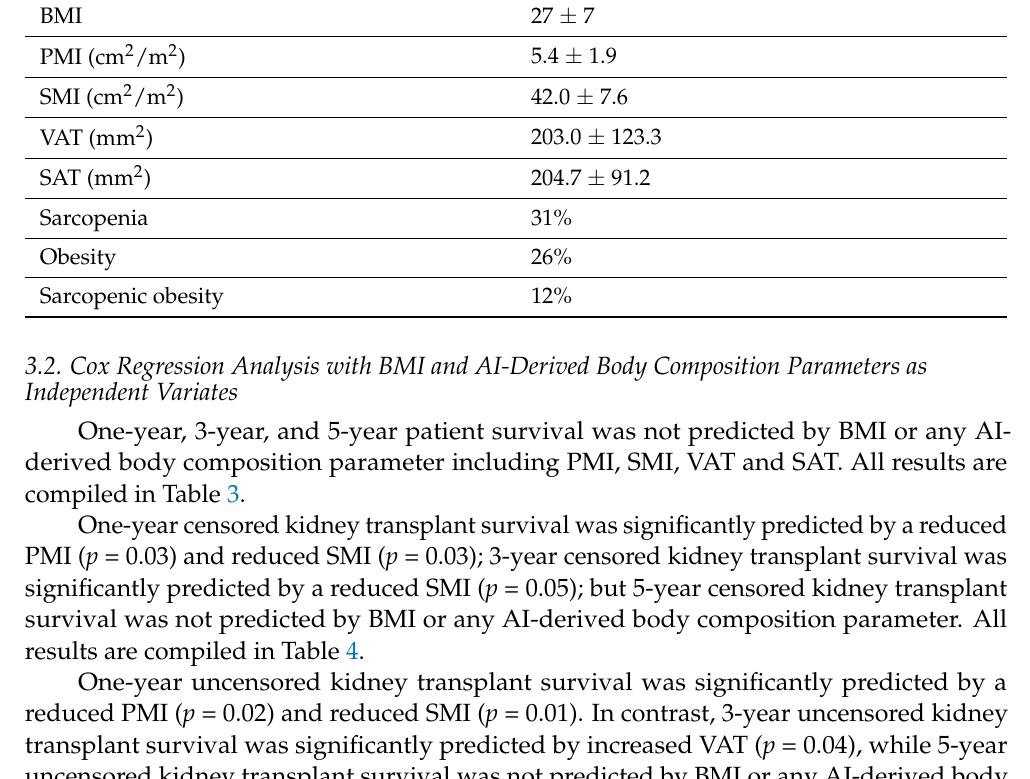
Table 2. Patient body composition parameters: BMI = body mass index. PMI = psoas muscle index. SMI = skeletal muscle index. VAT = visceral adipose tissue. SAT = subcutaneous adipose tissue. Body Composition